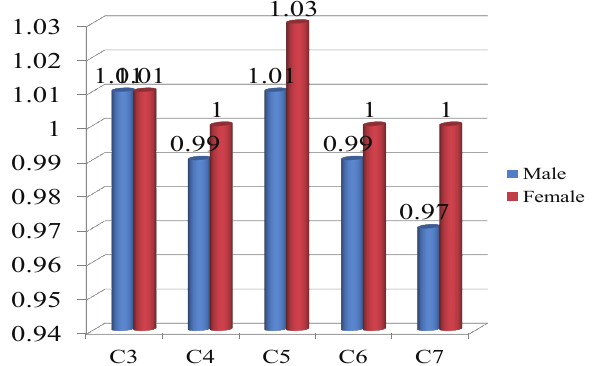
Figure 3: The mean Torg’s ratio in male and females Table 2: Sex wise comparison of the mean Torg’s ratio